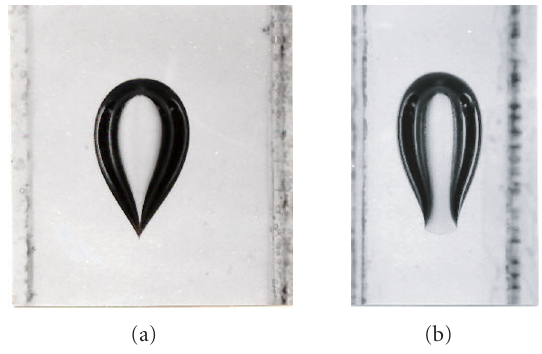
Figure 2.1. Two orthogonal views showing the (a) cusped and (b) broad shape of the trailing edge of an air bubble (2cm 3 ), rising in a viscoelastic liquid (S1). The two photographs are from Liu et al.